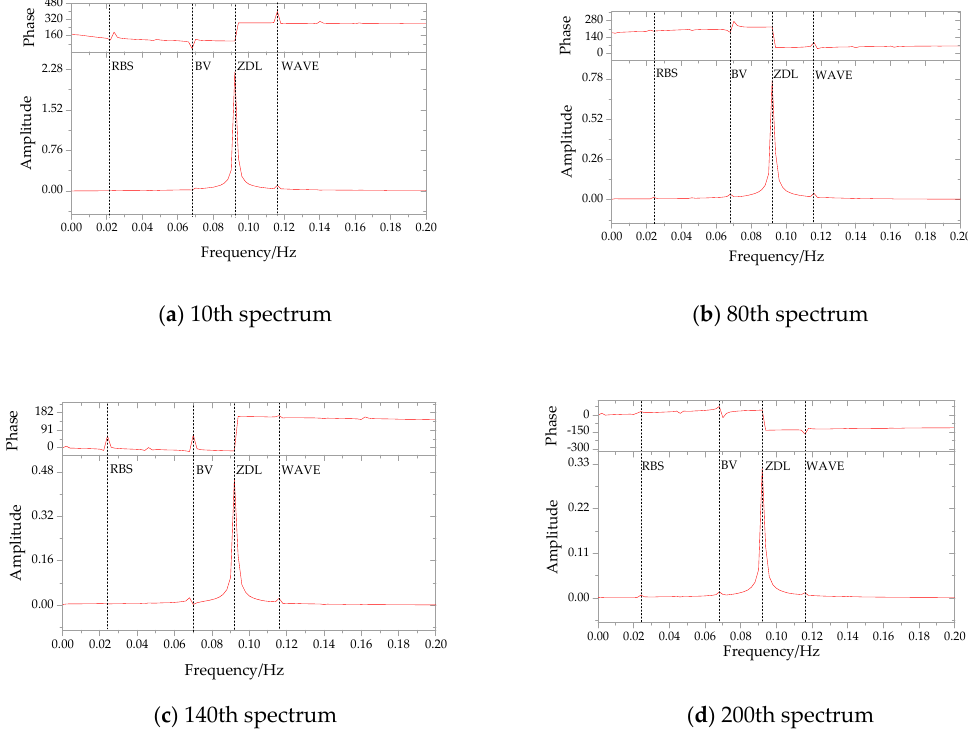
Figure 16. 10th – 200th spectrum of condition 1. Figure 16. 10th–200th spectrum of condition Table 12. Structural frequencies and amplitudes of different loads.